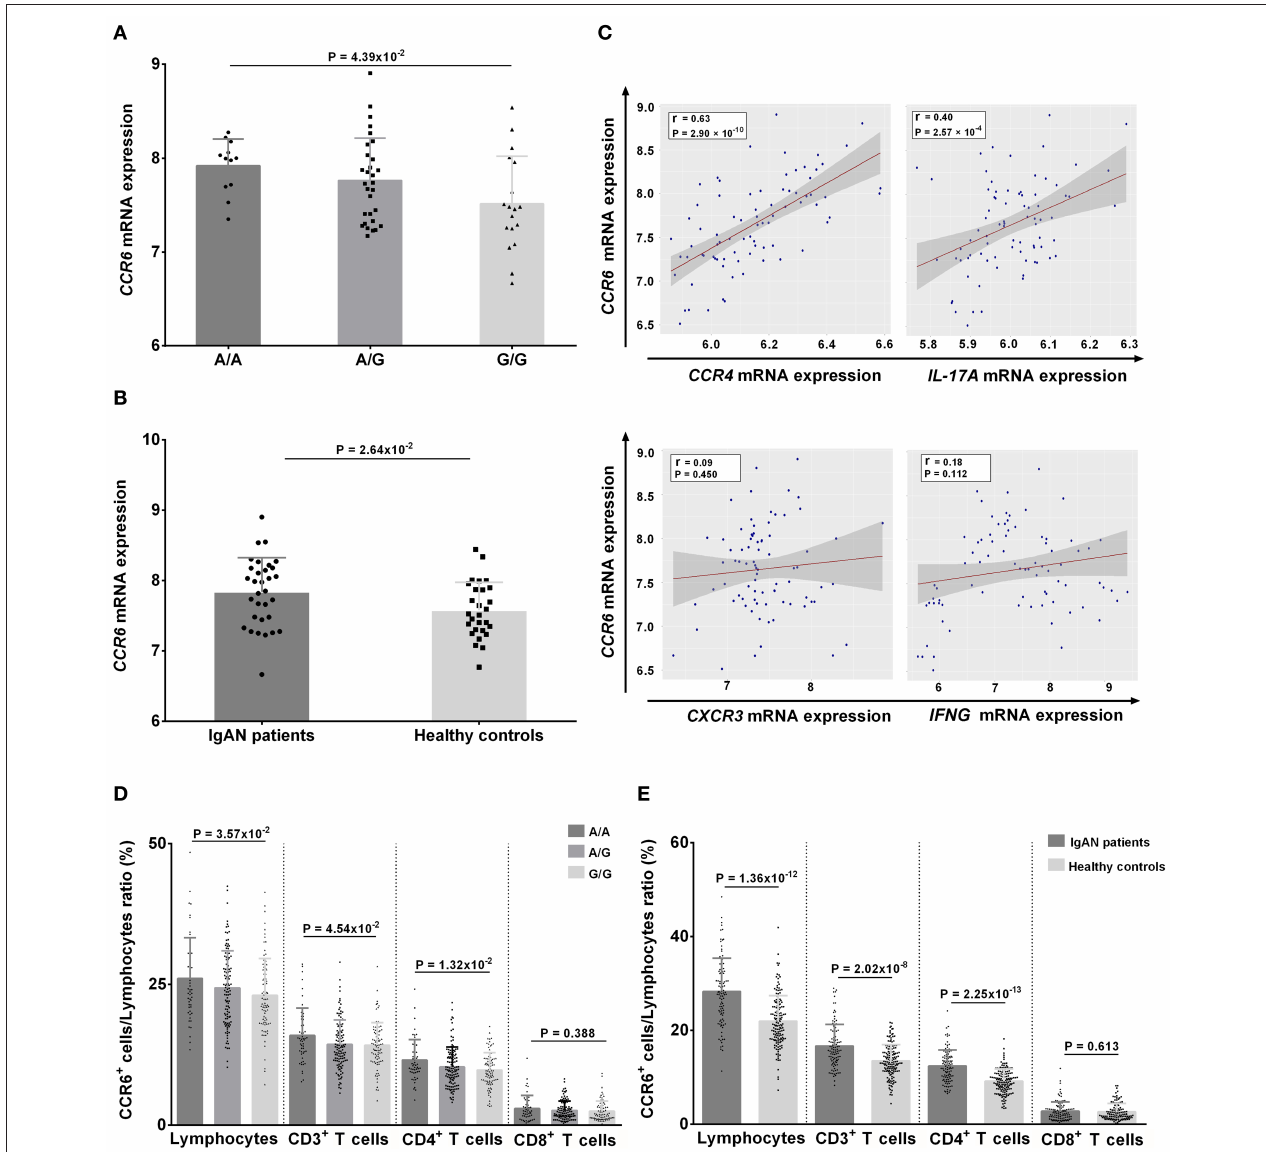
FIGURE 5 | CCR6 expression in individuals with rs3093023 genotypes. (A) The CCR6 mRNA expression in individuals with different rs3093023 genotypes. (B) The CCR6 mRNA expression in IgAN patients and controls. (C) The association between CCR6 mRNA expression and other cell surface markers of Th1 and Th17 cells. (D) The CCR6 protein expression in individuals with different rs3093023 genotypes. (E) The CCR6 protein expression in IgAN patients and